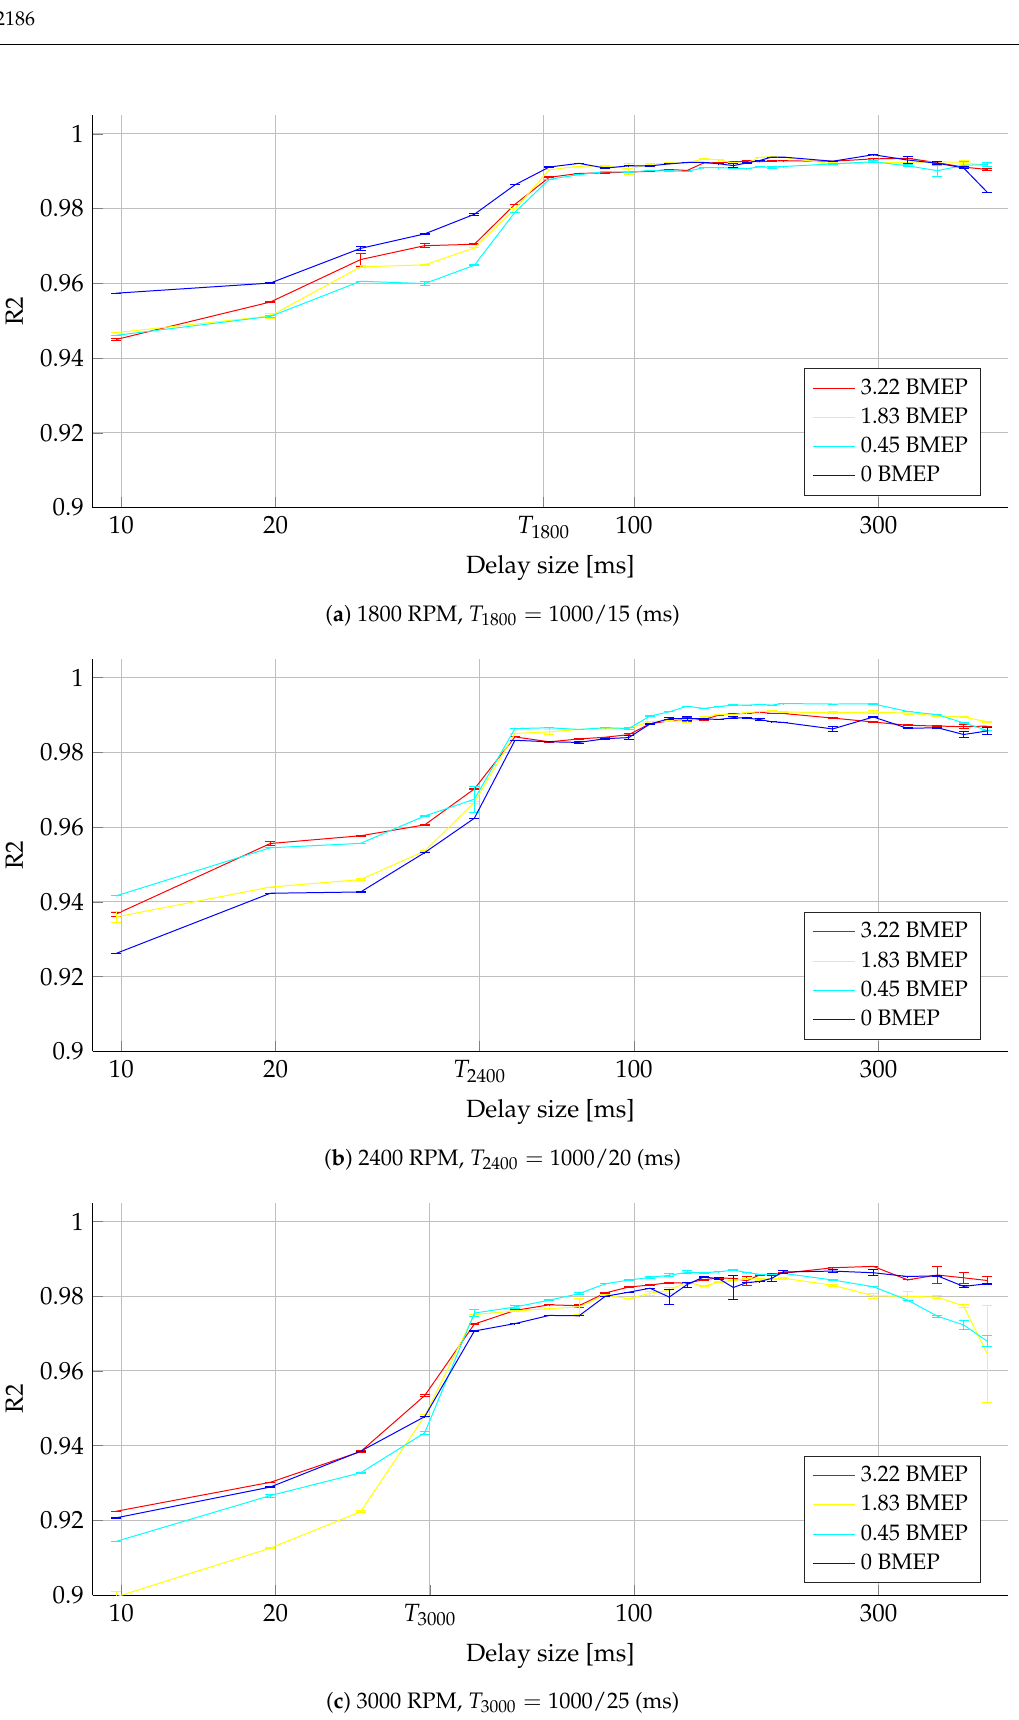
Figure 6. R2-based quality assessment results for tunning the TDNN’s time-delay (network complexity). The testing set results are depicted (average and standard deviation as error bars) by varying: the time delay (TDNN’s number of units K ), the speed (in rpm), and the load (applied current to the dynamometer in amperes). The horizontal axis is on a logarithmic scale. The fundamental period is highlighted as T RPM